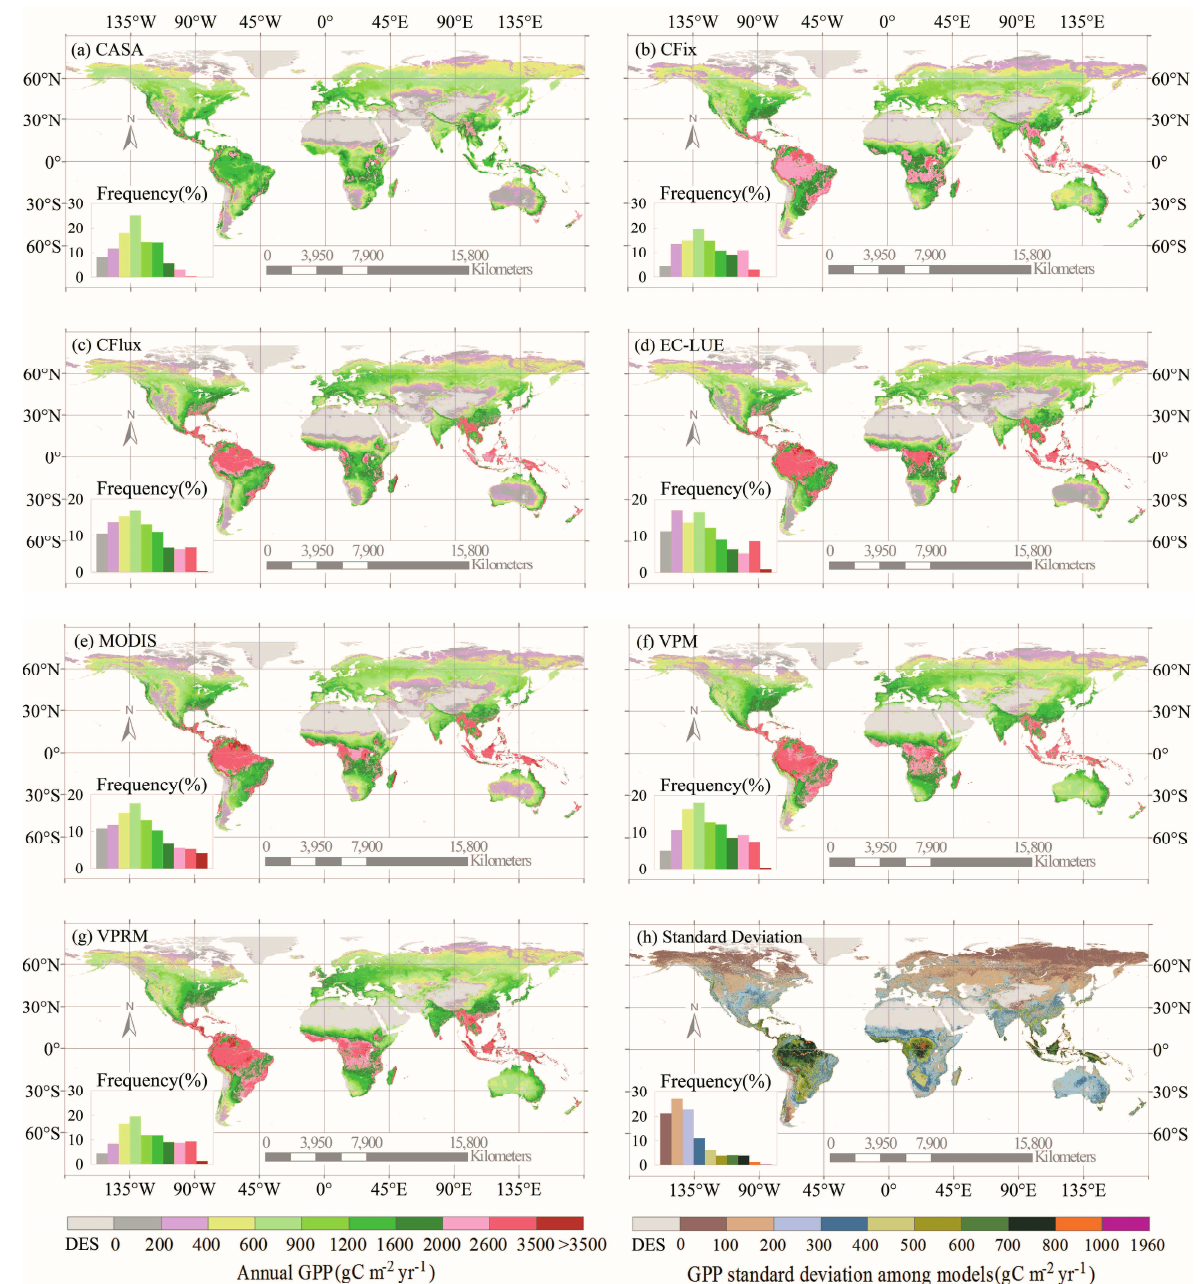
Figure 1. Spatial patterns of the global annual GPP estimates over the period 2000–2010 by ( a ) CASA; ( b ) CFix; ( c ) CFlux; ( d ) EC-LUE; ( e ) MODIS; ( f ) VPM; and ( g ) VPRM models; ( h ) the standard deviation of the GPP estimates among models. DES is no vegetation